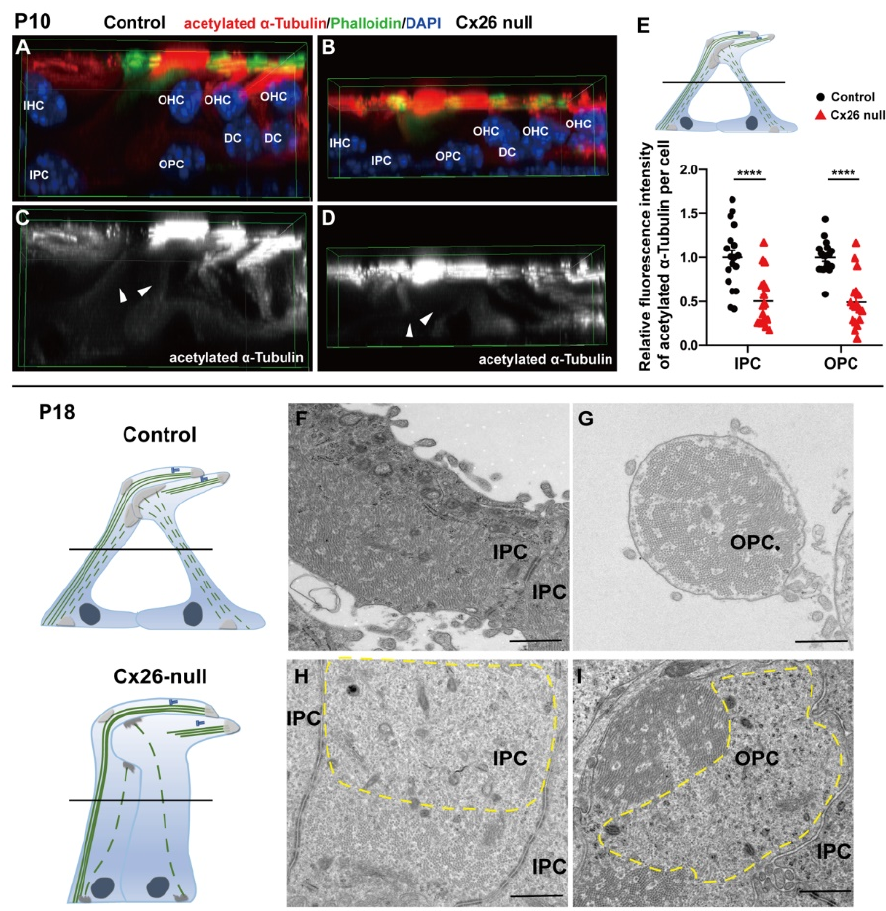
Figure 3. Reduced MT array anchored at non-centrosomal MTOCs away from centrosome in Cx26- null group. ( A – D ) Immunofluorescence staining of acetylated α -Tubulin at P10. Three-dimensional reconstruction of apical turn in the cochlea shows the local position of the organ of Corti. ( A , C ) width: 70.64 µ m, height: 70.64 µ m, depth: 35.00 µ m. ( B , D ) width: 70.64 µ m, height: 70.64 µ m, depth: 21.00 µ m. White arrowheads indicate the MT arrays anchored to non-centrosomal MTOCs away from centrosome. ( E ) Quantification of immunolabeling for acetylated α -Tubulin in IPCs and OPCs from the control and Cx26-null groups (18 IPCs and 18 OPCs from 3 mice in each group) at P10. Schematic diagrams (top) display the assessed levels of the PCs. The relative fluorescence intensity of acetylated α -Tubulin: 1.00 ± 0.09 (control) vs. 0.50 ± 0.07 (Cx26 null) in IPCs, 1.00 ± 0.04 (control) vs. 0.49 ± 0.07 (Cx26 null) in OPCs—data are expressed as mean with SEM, **** p < 0.0001; ( F – I ) TEM cross-sections obtained from the middle turn in the cochlea show MT arrays in IPCs and OPCs at P18. Schematic diagrams (left) display the assessed levels of these cross-sections (right). Cluttered and absent MTs (broken yellow lines) were observed in Cx26-null group ( H , I ). P: postnatal,